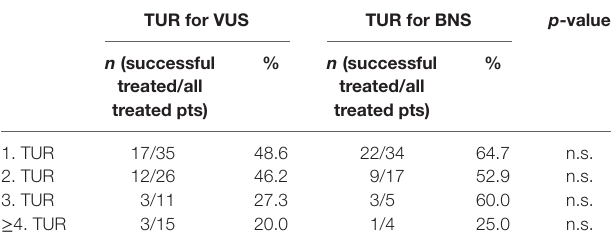
TaBle 4 | Success rates of patients treated by TUR for vesicourethral stenosis (VUS) and bladder neck stenosis (BNS), stratified by number of procedures.